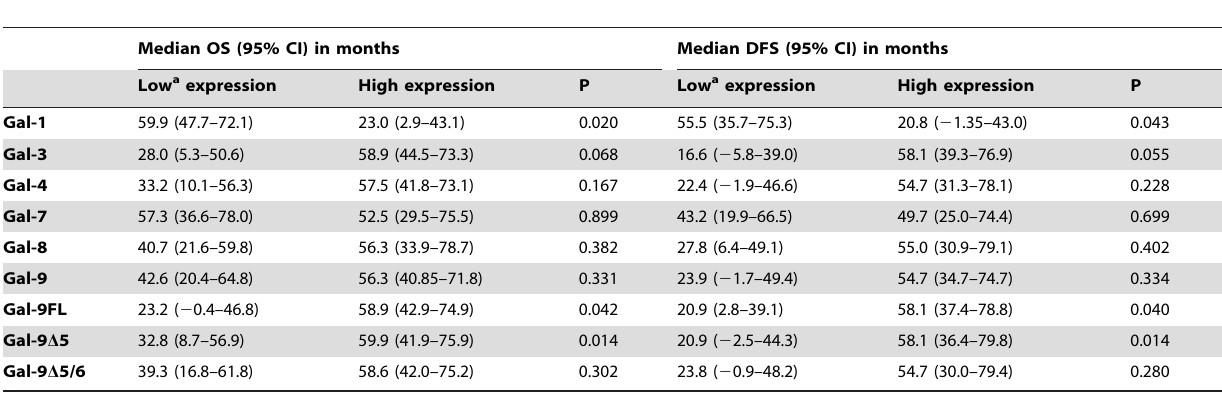
Table 4. Kaplan-Meier estimates of median OS and DFS in early stage NSCLC patients with galectin expression below or above the median level.